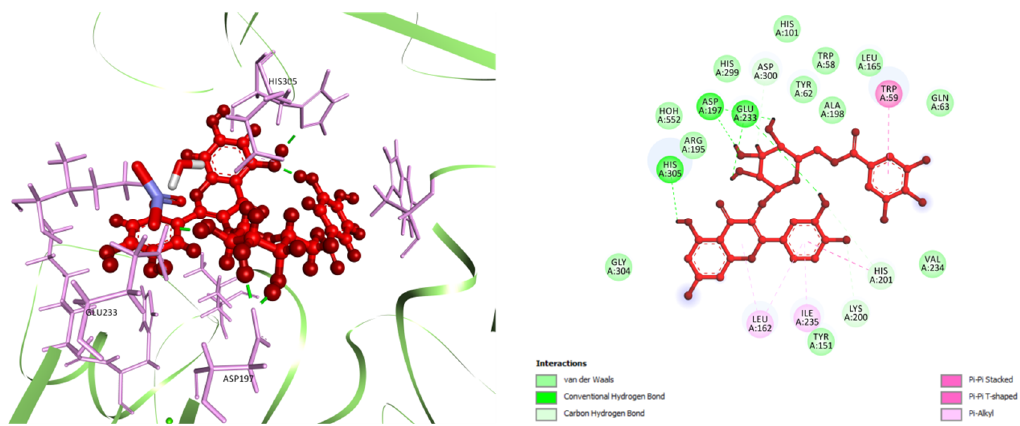
Figure 5. Best ranked docking pose (left) and 2D visualization of the interactions (right) of Q3DG in the catalytic pocket of HPA (PDB ID: 3BAJ). Q3DG, quercetin 3-O-(6″-galloyl)-β-D-galactopyra- noside.